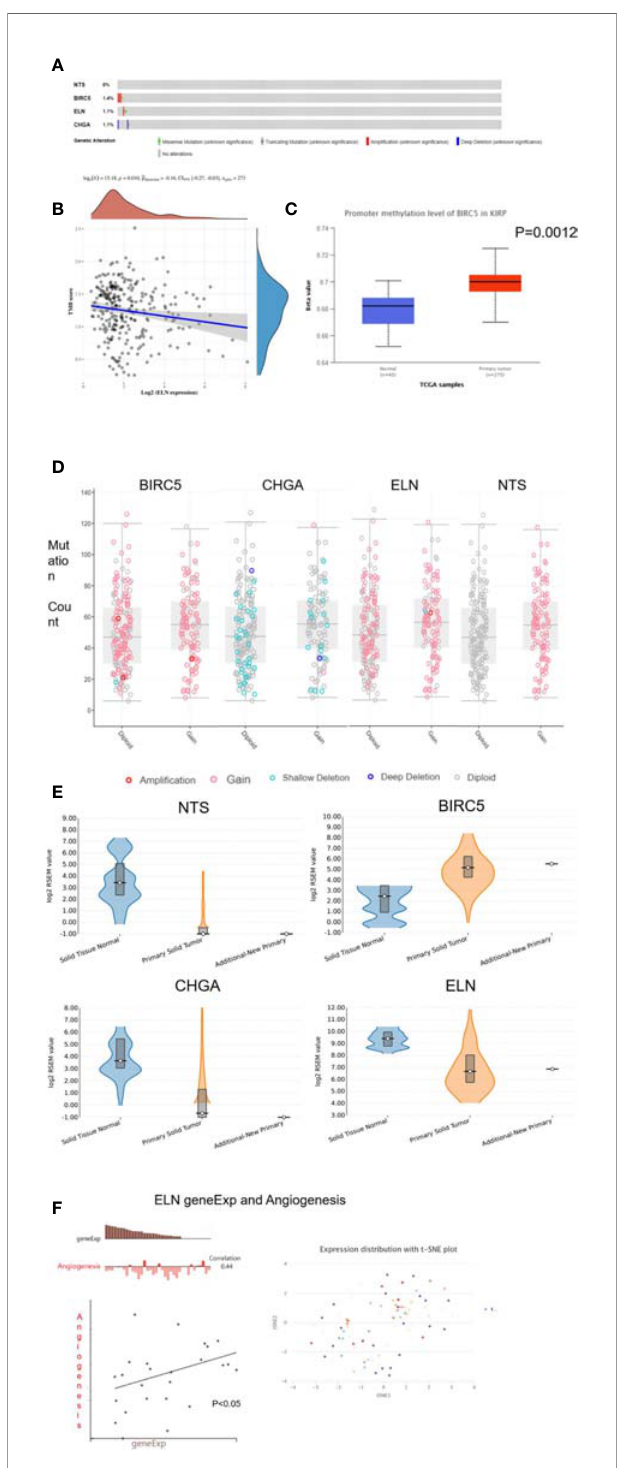
FIGURE 4 | The analysis of hub DEGs ’ DNA methylation, TMB, CBV, and variable shear. (A) The genetic alterations of four hub DEGs; (B) The correlation between ELN geneEpx and TMB; (C) the correlation between BIRC5 geneEpx and DNA methylation level; (D) the correlation between hub DEGs geneEpx and CNV; (E) the correlation between hub DEGs geneEpx and variable shear; (F) the correlation between ELN geneEpx and angiogenesis.